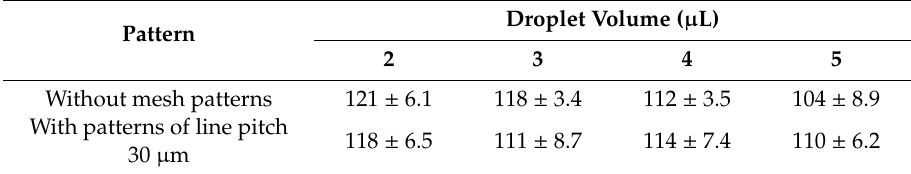
Table 1. Contact angle of the droplet on XO RGP contact lens with and without mesh patterns (Unit: ◦ ). Pattern